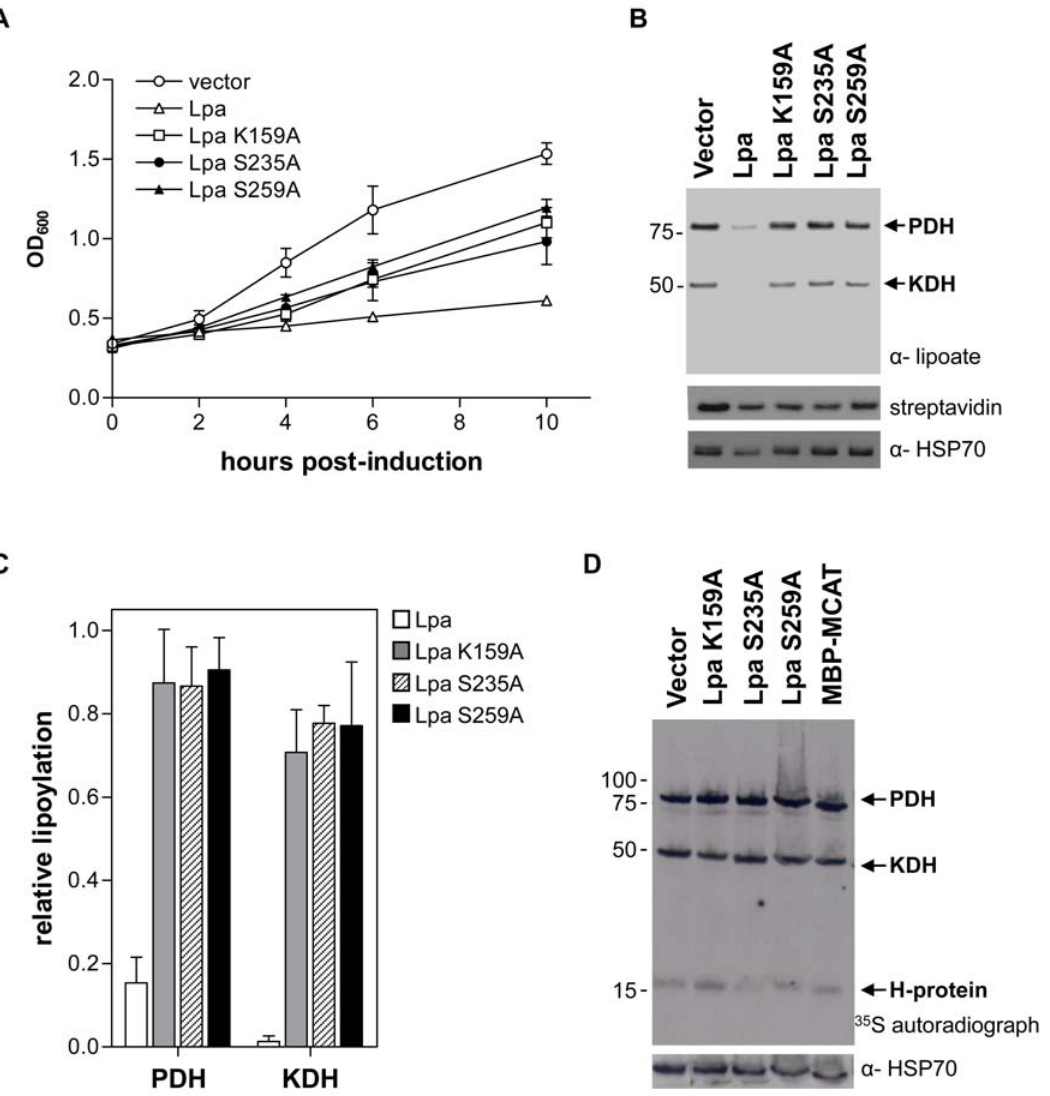
Figure 4. Growth, lipoylation, and biotinylation of cells expressing Lpa and Lpa active site mutants. ( A ) Growth assay of E. coli BL21 cells expressing Lpa (open triangles) compared to vector alone (open circles) and the three active site mutants: Lpa K159A (open squares), Lpa S235A (closed circles), and Lpa S259A (closed triangles). The OD 600 of cultures was measured at the time of induction with IPTG and at 2, 4, 6, and 10 hours post-induction. Error bars represent the standard deviation of three replicates from a representative growth assay. ( B ) Anti-lipoic acid and streptavidin affinity blots to determine levels of PDH and KDH lipoylation and BCCP biotinylation in E. coli expressing empty vector, Lpa, and Lpa active site mutants. ( C ) Densitometry analysis of PDH and KDH lipoylation in cells expressing Lpa and Lpa active site mutants. To determine the level of KDH and PDH lipoylation, the anti-lipoic acid signal was normalized to the anti-HSP70 loading control signal. The fraction of lipoylation in cells expressing Lpa or the Lpa active site mutants relative to cells expressing vector alone was then determined. Error bars represent the SEM for the fraction of lipoylation for three independent western blots. ( D ) Autoradiograph of KER176 cells expressing vector alone, the Lpa active site mutants, and MBP-MCAT grown in minimal medium supplemented with 35 S-lipoic acid. After a 6 hour induction at 20 u C, cell samples were normalized by OD 600 and protein extracts were separated by SDS-PAGE and analyzed by autoradiography. Equal sample loading was assessed by anti-HSP70 western